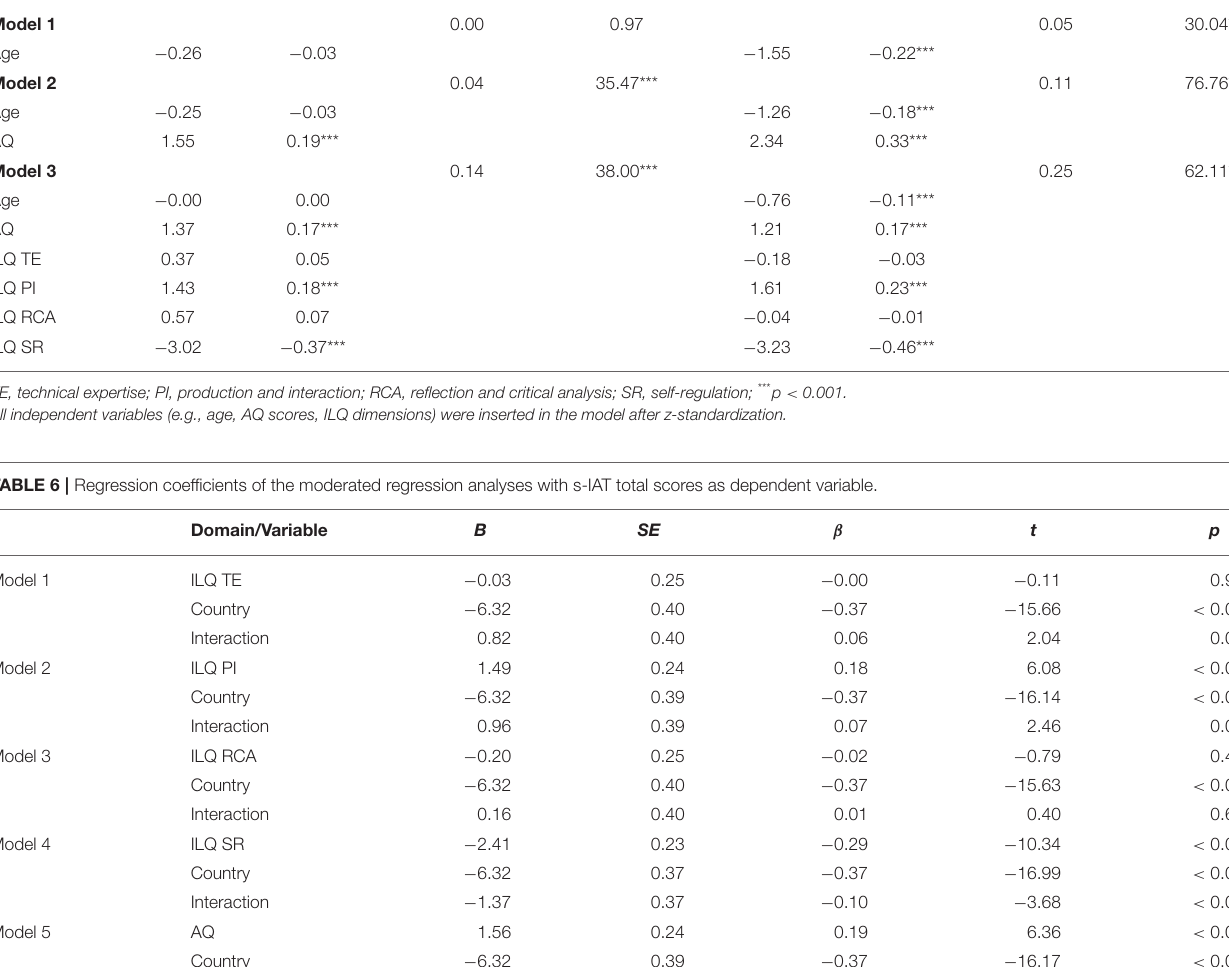
TABLE 5 | Results of hierarchical regression analysis for variables predicting the s-IAT in China and Germany. China ( n = 929) Germany ( n = 595) Predictors